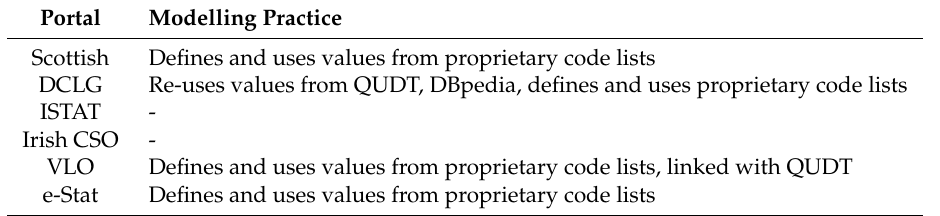
Table 12. Modelling practices of data portals regarding the values (code list) of the unit of measure. Portal Modelling Practice